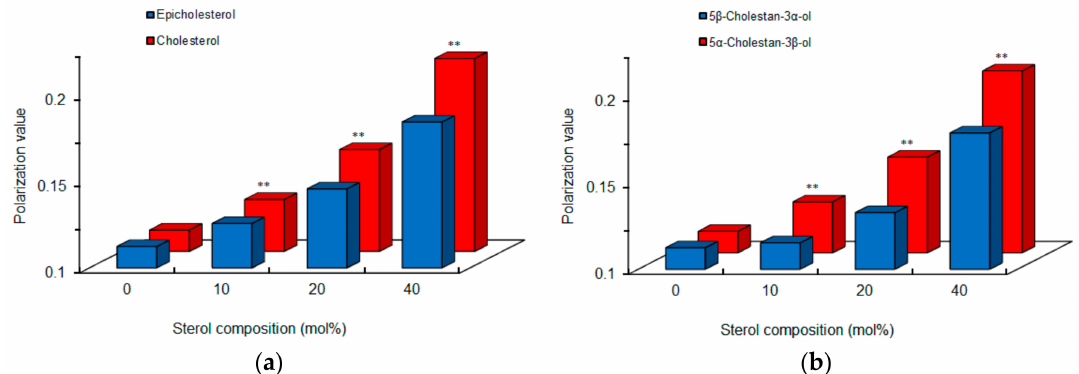
Figure 5. Comparisons of cardiomyocyte-mimetic membranes prepared with epimeric ( a ) and diastereomeric ( b ) sterols. ** p <0.01 compared with epicholesterol or 5 β -cholestan-3 α